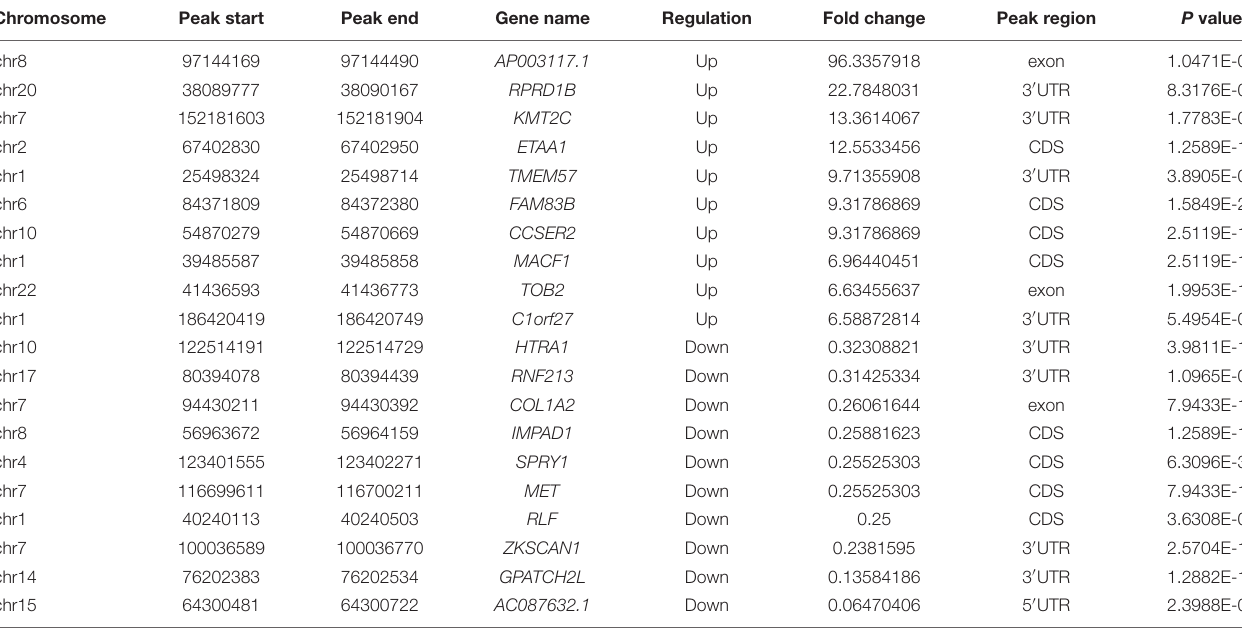
TABLE 1 | Top 20 altered m6A peaks of m6A-modified mRNA in the pterygium vs conjunctiva. Chromosome Peak start Peak end Gene name Regulation Fold change Peak region P